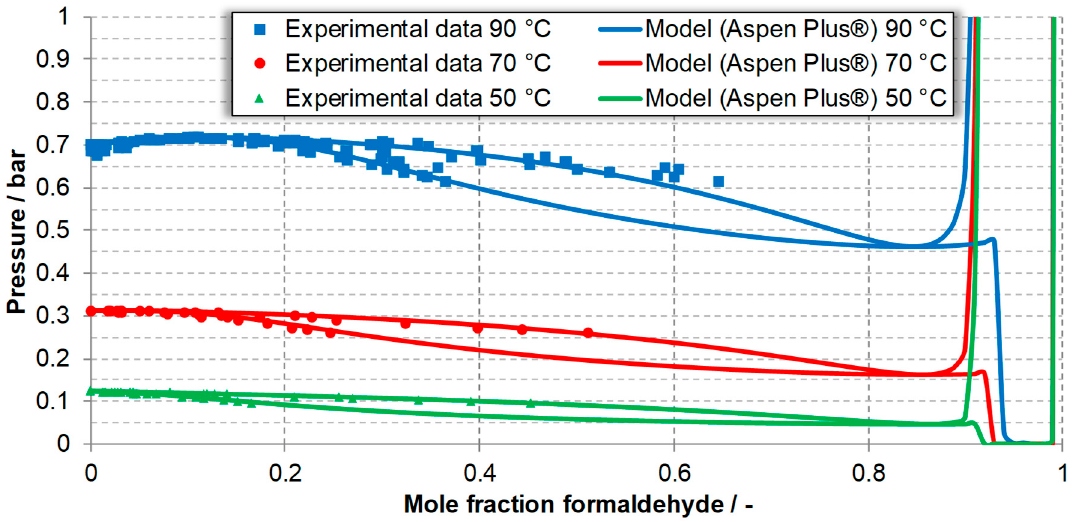
Figure 7. Phase equilibrium of the FA-W-system for different temperatures calculated using Aspen Plus ® , compared to the experimental data [32,34,64,65].